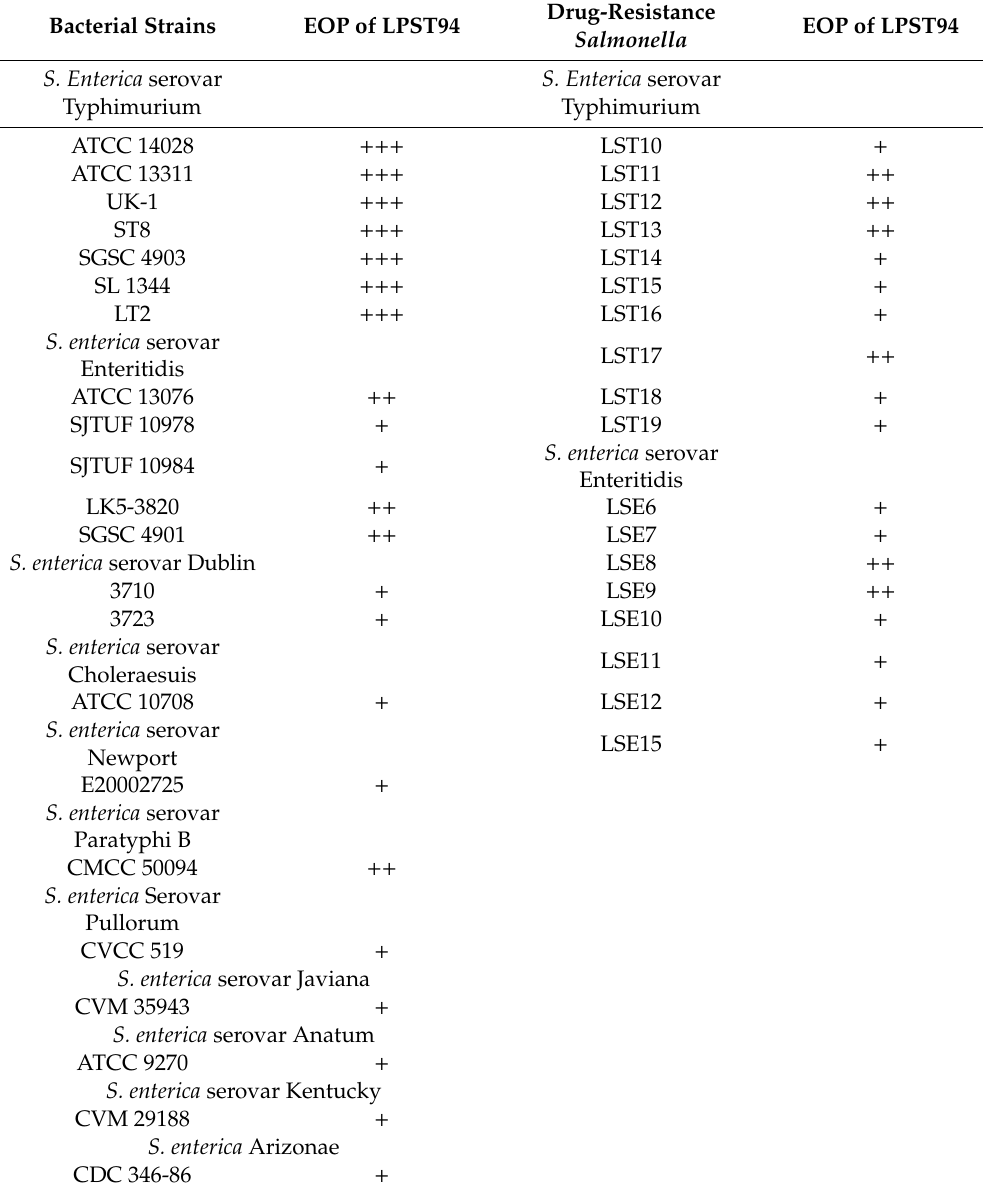
Table 2. E ffi ciency of plating (EOP) by phage LPST94 against di ff erent Salmonella serovars. Bacterial